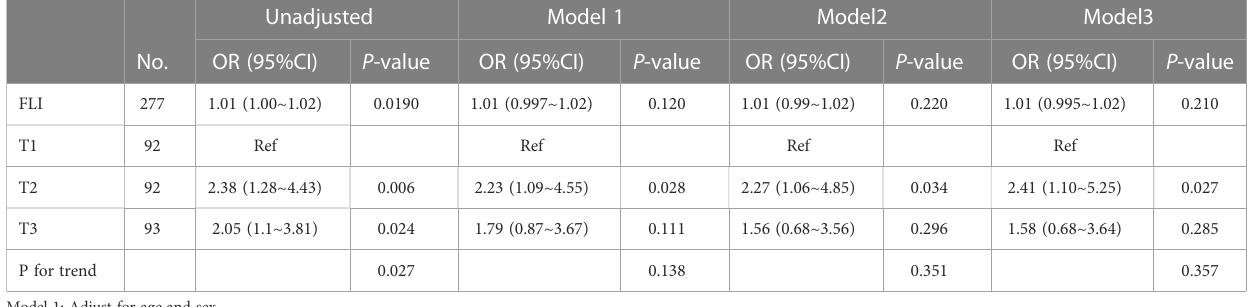
TABLE 2 Multivariate logistic regression analyses of associations between FLI and CIMT.